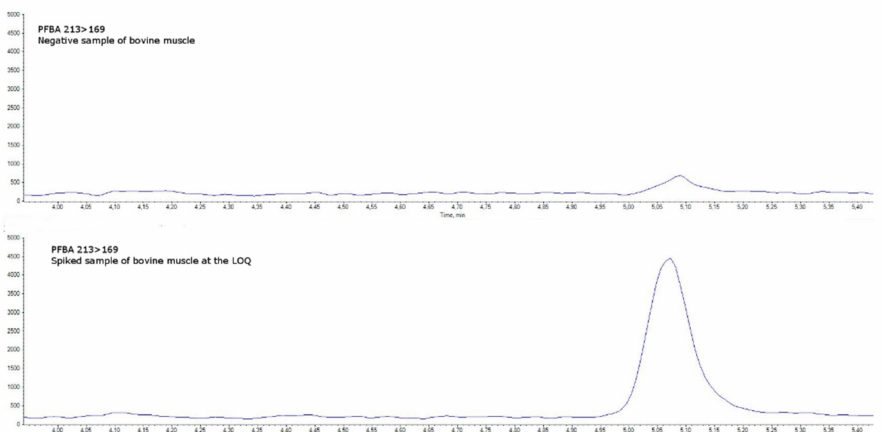
Figure 4. (PFBA quantitative transition 213 > 169). Comparison between a negative sample of bovine muscle (upper chromatogram) and a spiked sample of bovine muscle at the limit of quantification (lower